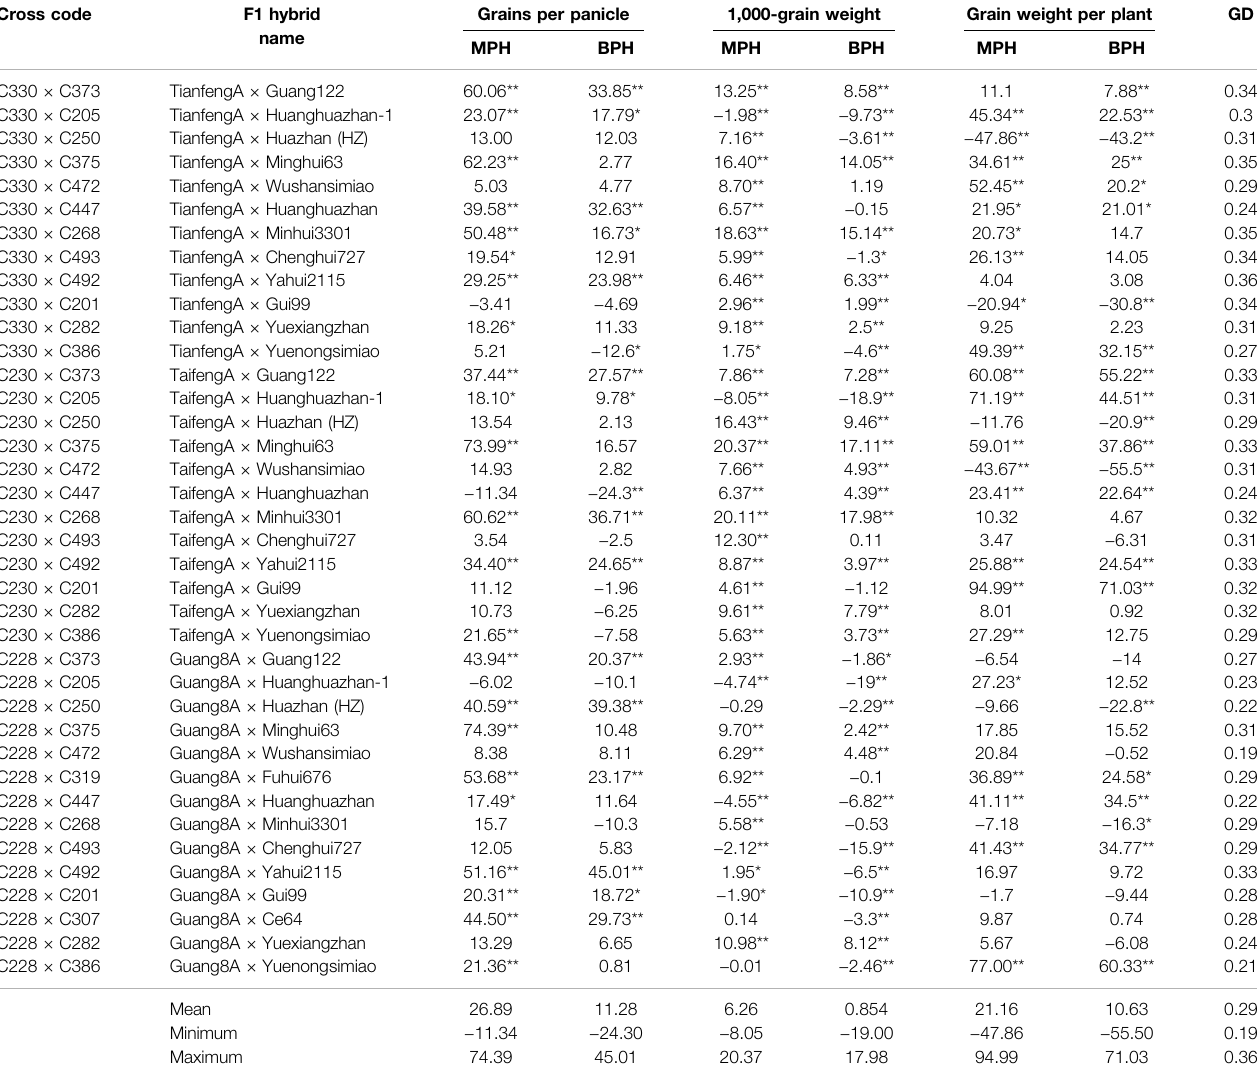
TABLE 5 | Mid-parent and better-parent heterosis estimates for grains per panicle, 1,000-grain weight, grain weight per panicle, and genetic distances between their corresponding parents. Cross